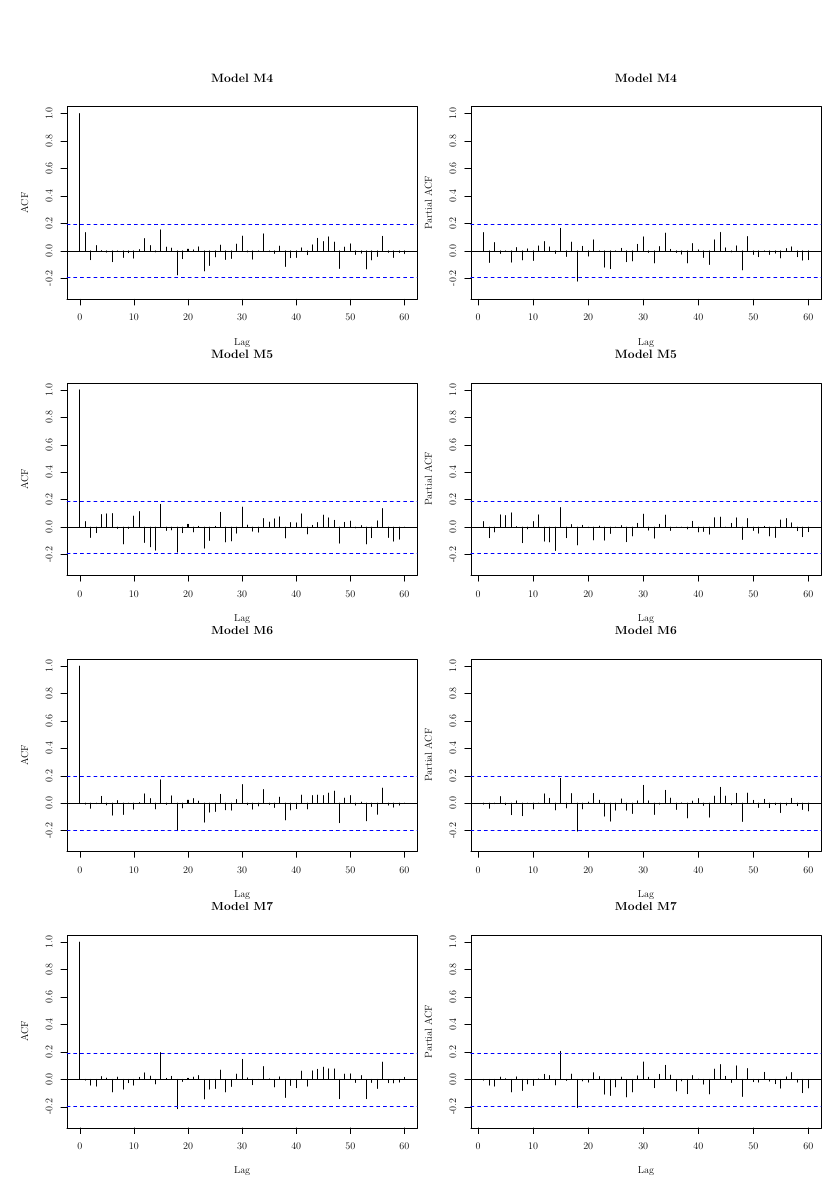
Figure 14 – Correlograms of the residuals from Model M4 – M7 fit for the time series of Canadian